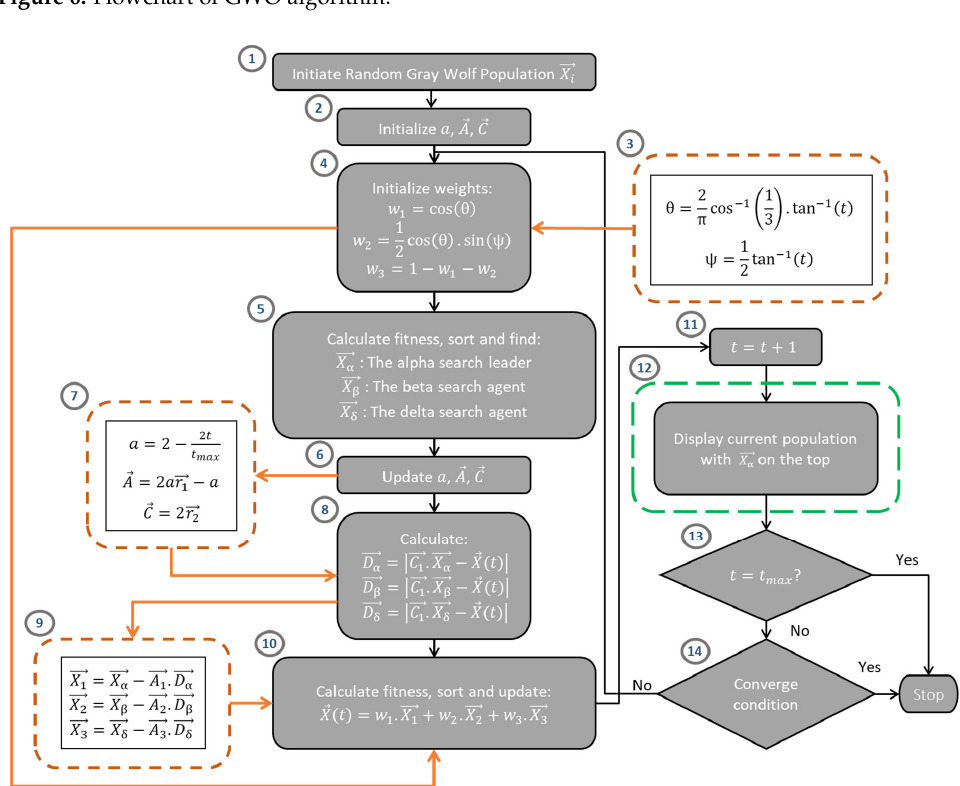
Figure 7. Flowchart of WVGWO algorithm.